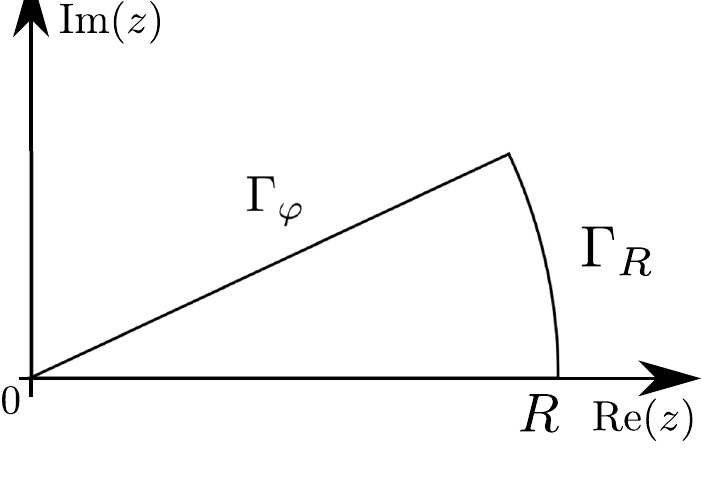
Figure 1 . The path Γ ϕ